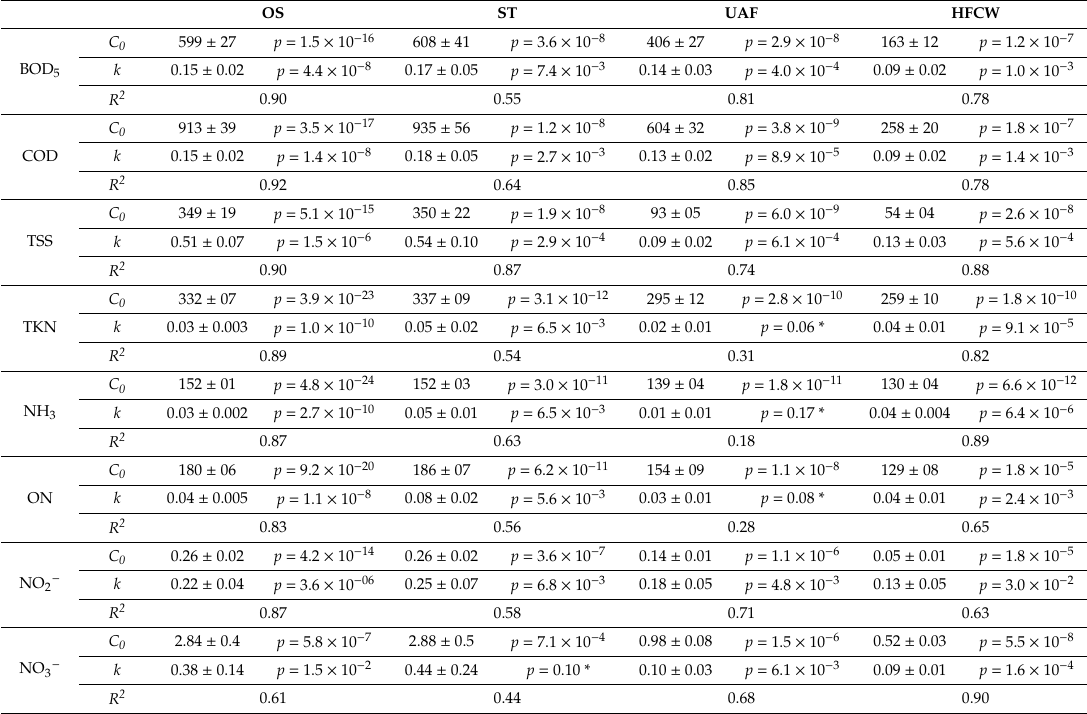
Table 4. Kinetic parameters for first-order